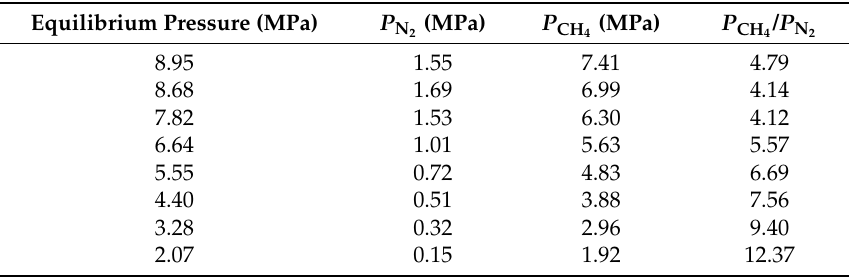
Table 4. The partial pressures of methane and nitrogen and their